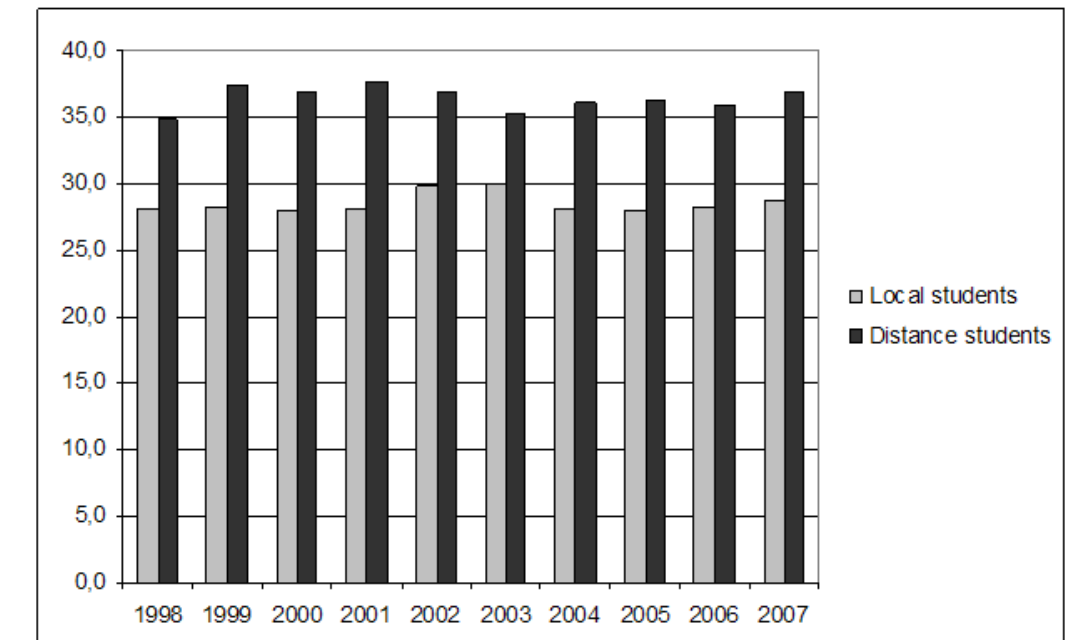
Figure 1. The average age of students at UNAK